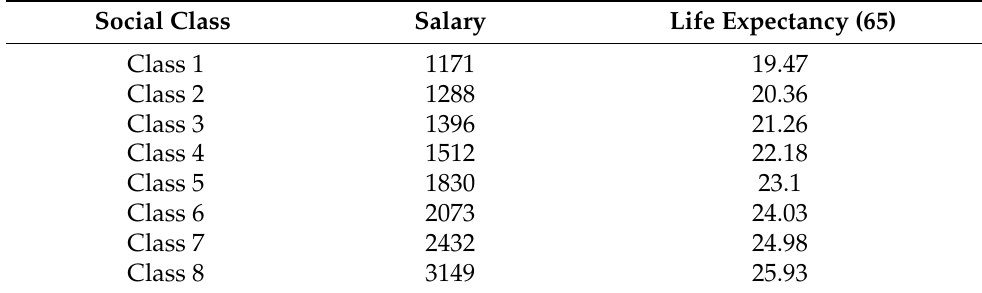
Table 1. Life expectancy with salary level.